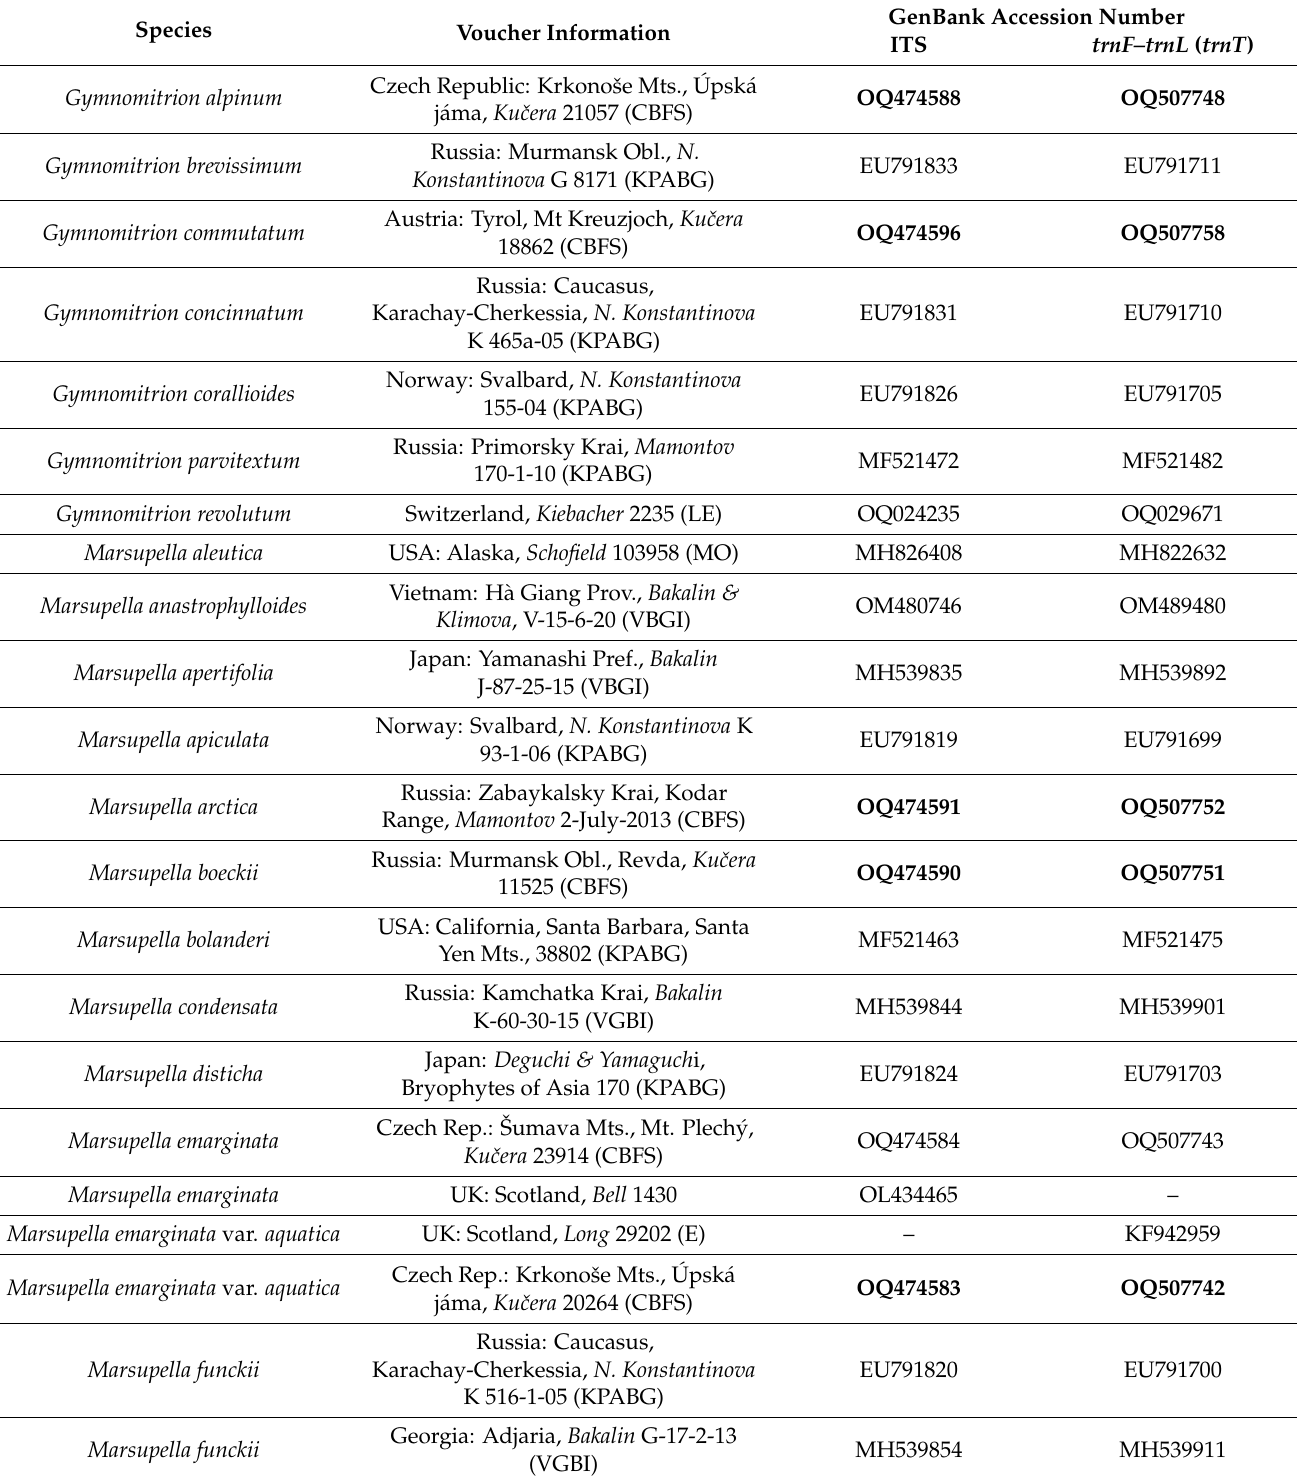
Table A1. Voucher information and GenBank accession numbers (ordered trnL–trnF (– trnT ), ITS) of the specimens used in the molecular study. Newly obtained sequences are printed in bold. Accessions used in the study of Bell are identified using BOLD Process IDs which appear in the final BOLD and GenBank records upon their